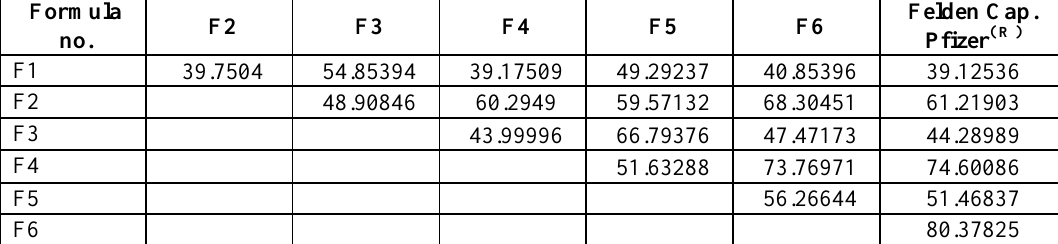
Table 3: Values for the similarity factor f